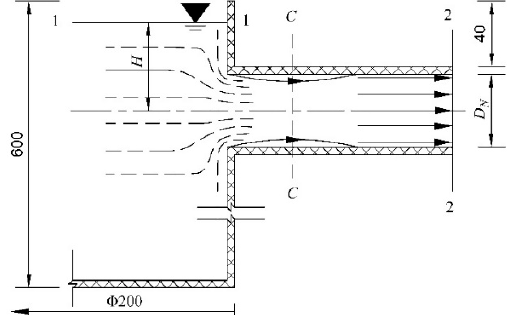
Figure 2. Flow analysis at the outlet of the designed device. 1-1 is the water surface section, H is the height of water surface from the center of the outlet pipe, C-C is the shrink section, 2-2 is outlet section, D N is the diameter of the outlet pipe.